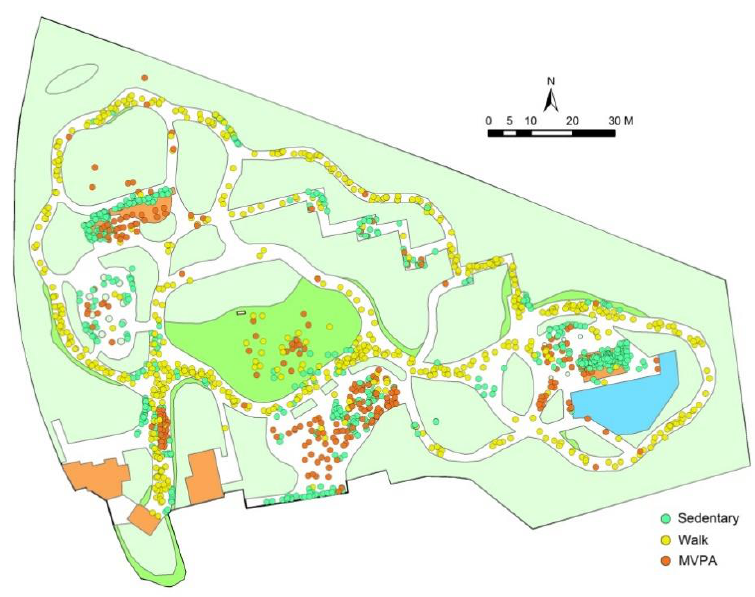
Figure A2. Behavior map of Liangcheng Park showing the distribution of users (the data were from nine rounds of observations: morning, noon and afternoon, three times each).